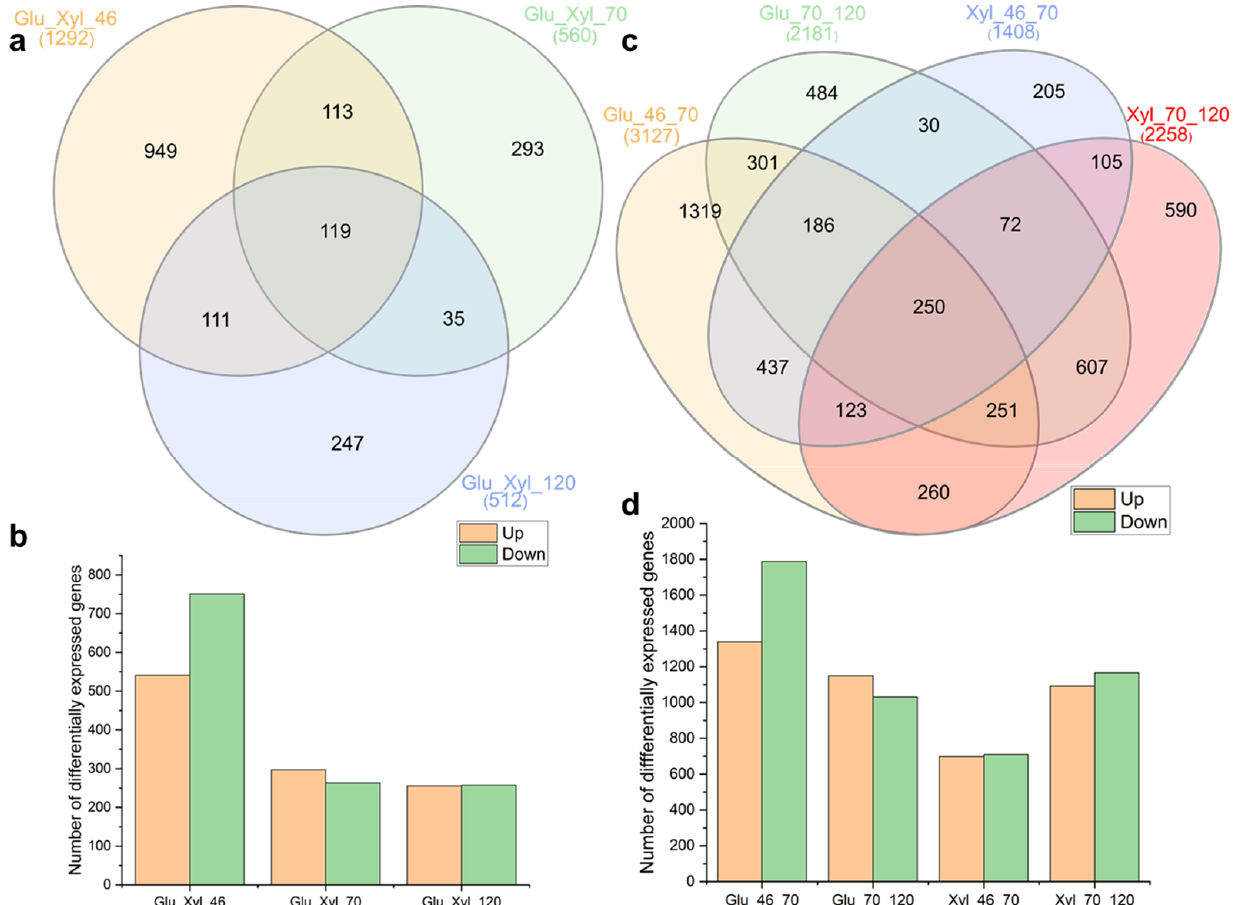
Figure 4. Differential gene expression (DGE) in Saitozyma podzolica DSM 27192 during fed batch cultivation on glucose and xylose. ( a ) Overlapping DGE for comparison between glucose and xylose grown cultures, ( b ) Number of up and down regulated genes in xylose grown cultures relative to glucose, ( c ) Overlapping DGE across the three time points in glucose and xylose grown cultures and ( d ) Number of up and downregulated genes across the three time points in glucose and xylose grown cultures.